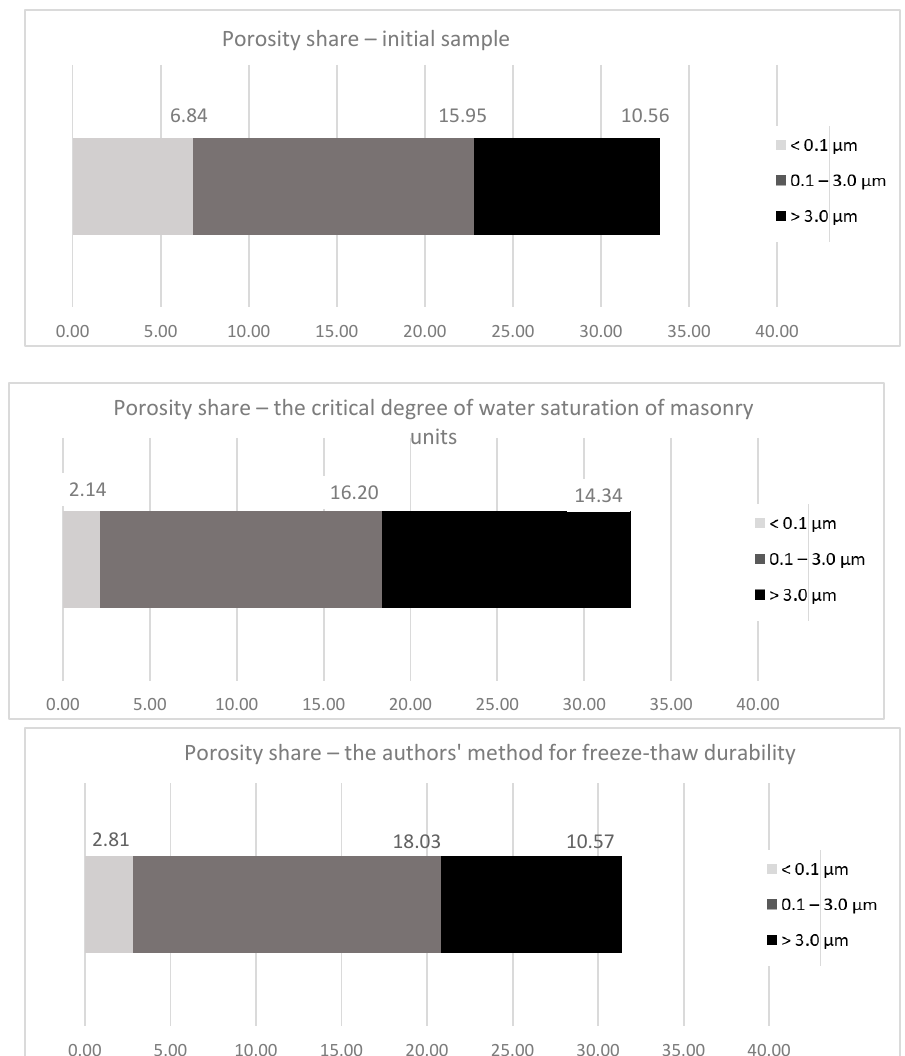
Figure 6. Typical porosity ranges in the tested clay bricks. Porosity changes affect the moisture properties of the tested ceramic building mate- rials. The absorption of the samples increases in relation to the initial material (Table 3) by about 1% regardless of the method of freezing and thawing cycles used.